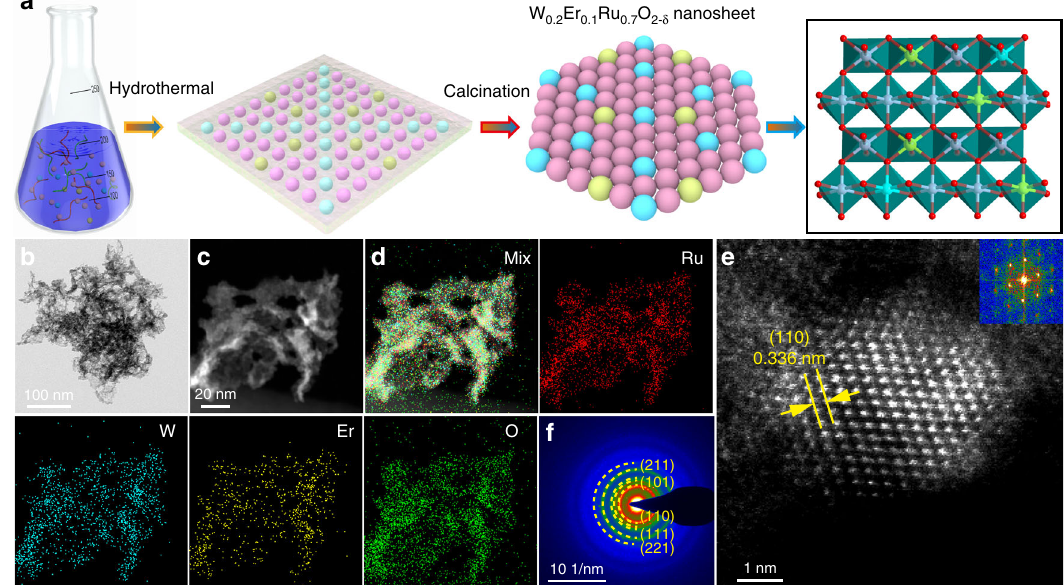
Fig. 3 The designing strategy and TEM characterization for the prepared W 0.2 Er 0.1 Ru 0.7 O 2 − δ nanosheets. a Schematic route for synthesis of W 0.2 Er 0.1 Ru 0.7 O 2 − δ nanosheets. b TEM image, c HAADF-TEM image, d the corresponding elemental maps, e HR-TEM image (inset: Fourier transform analyses for W 0.2 Er 0.1 Ru 0.7 O 2 − δ ), and f SAED image for the W 0.2 Er 0.1 Ru 0.7 O 2 − δ